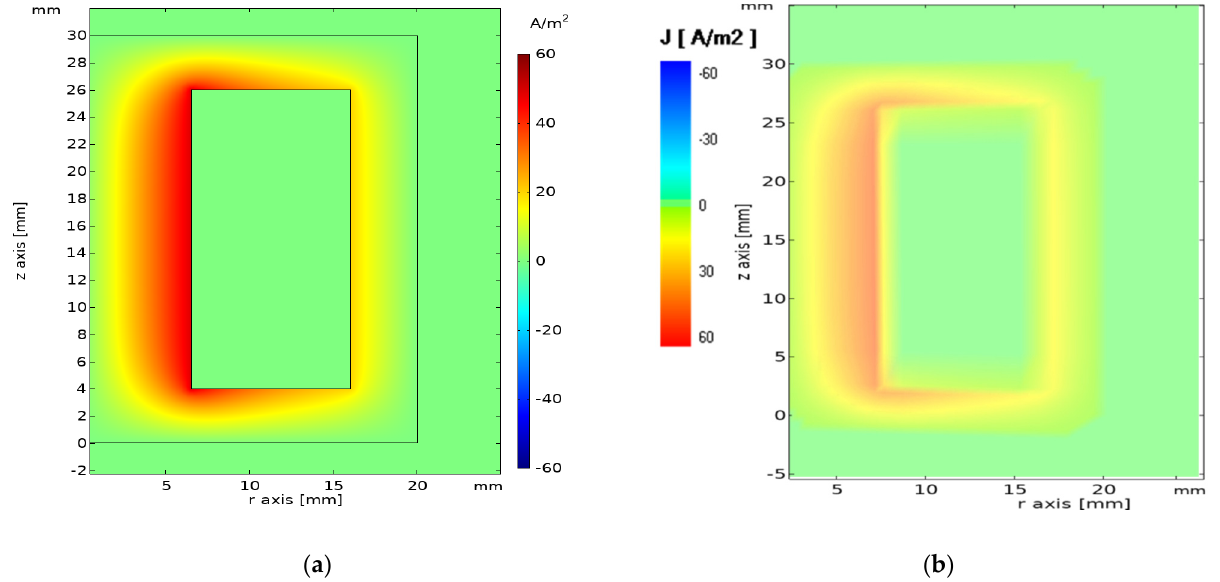
Figure 23. ( a ) Distribution of the eddy current density in the ferrite core at time t = 9 us obtained by Comsol Mutliphysics. ( b ) Distribution of the eddy current density in the ferrite core at time t = 9 us obtained by the proposed approach.